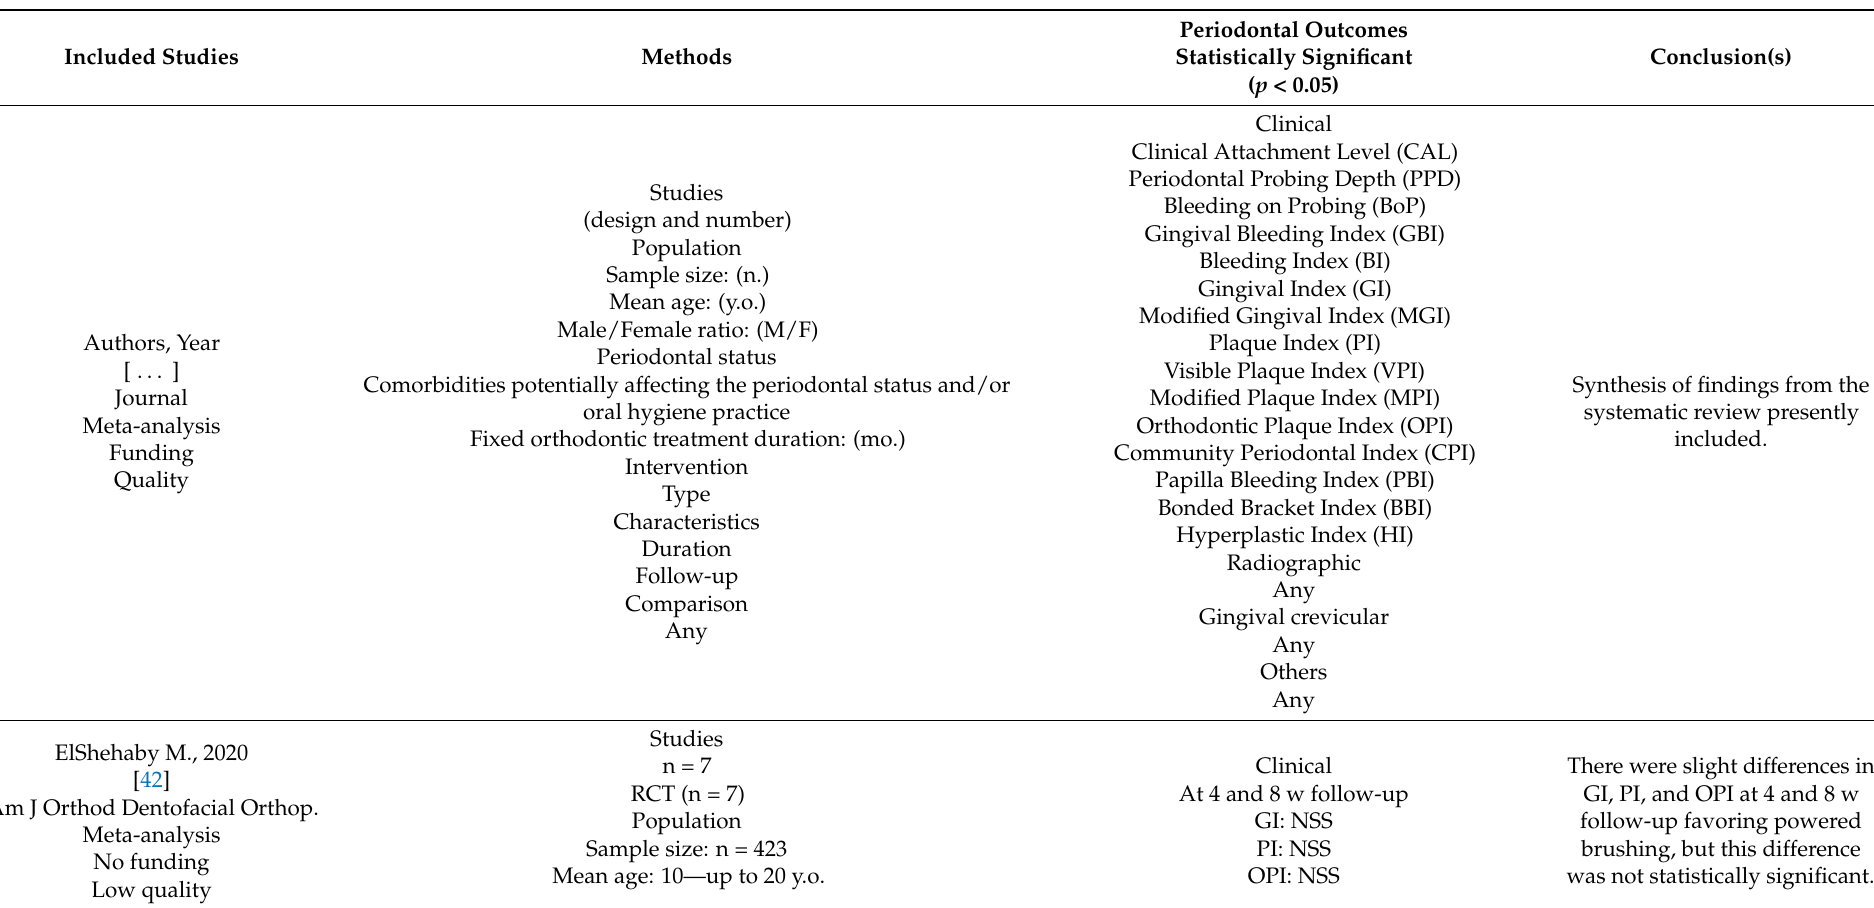
Table 1. Data collected from the studies included in the present umbrella review: general information: first author, year, journal of publication, reference number, meta-analysis, funding, quality; methods: characteristics of the study (design and number), participants (sample size, age, gender, periodontal status, comorbidities potentially affecting periodontal status, and/or oral hygiene practice, fixed orthodontic treatment duration), intervention (type, characteristics, duration, and follow-up), and comparison; periodontal outcomes statistically significant: clinical and radiographic periodontal parameters and gingival crevicular inflammatory mediators;